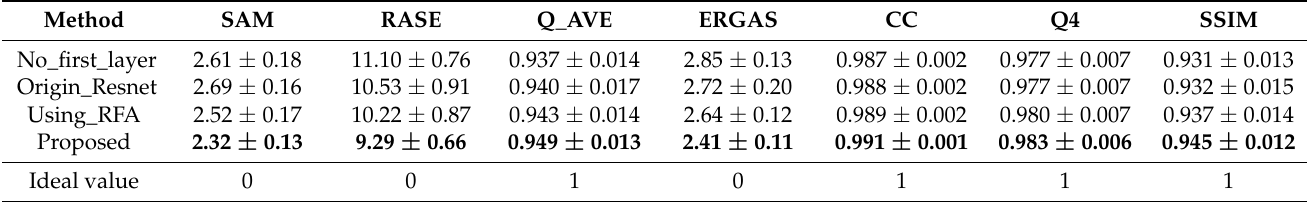
Table 10. Results of the quantitative evaluation of double-stack aggregated skip connections and CRAB (best results in